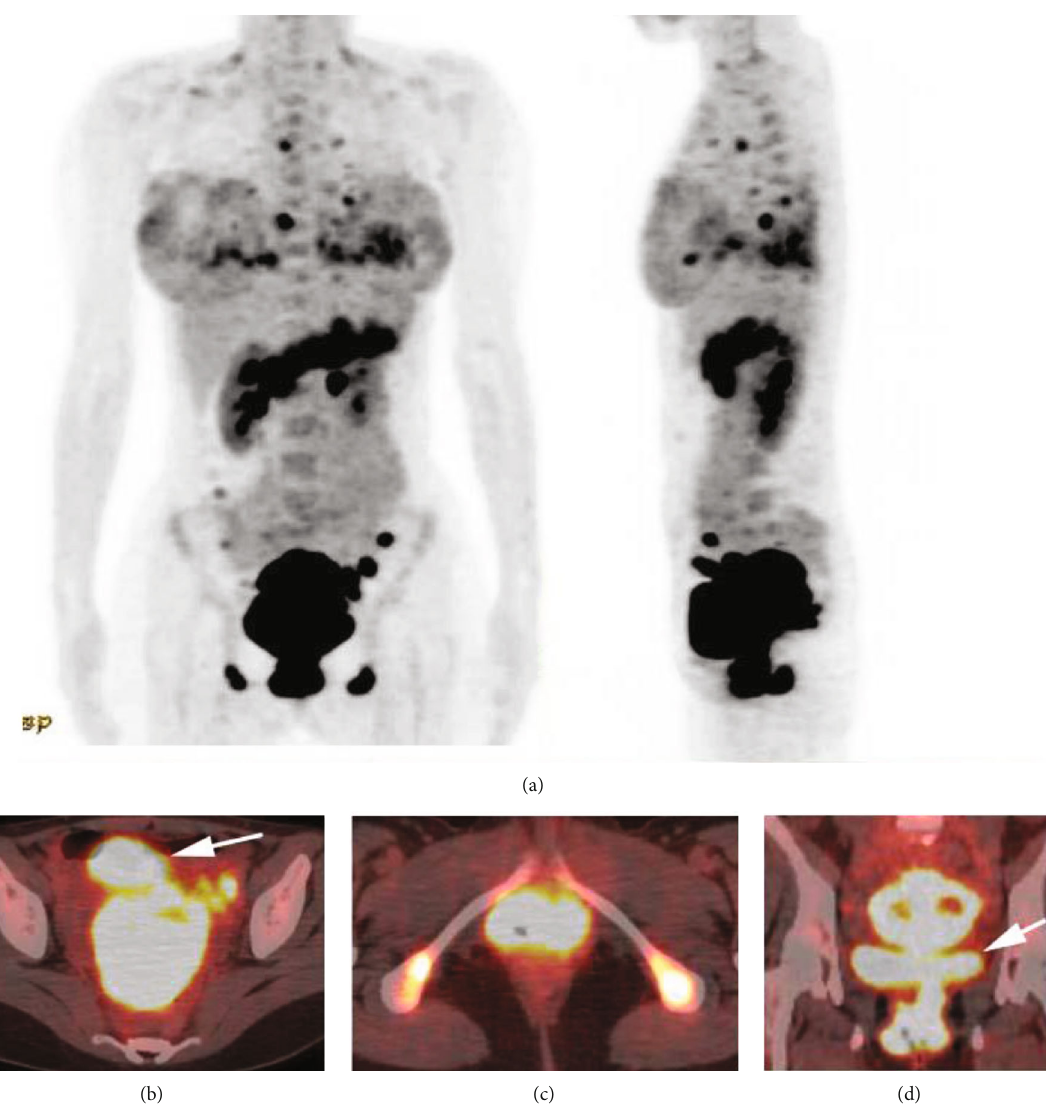
Figure 4: (a) FDG-PET/CT images of the whole body. Abnormal uptake of FDG was observed through the whole body, although it was strongest in the reproductive tract. (b) Axial FDG-PET/CT images of the uterine body. Urine (arrow) obscured FDG accumulation in the reproductive tract, whereas the uterus and the left ovary showed clear uptake of FDG. (c) Axial image of the ischial tuberosities and the vulva. (d) Coronal image of the uterus and the vagina. Excreted FDG into the bladder (arrow) was overlaid on the uptake in the reproductive